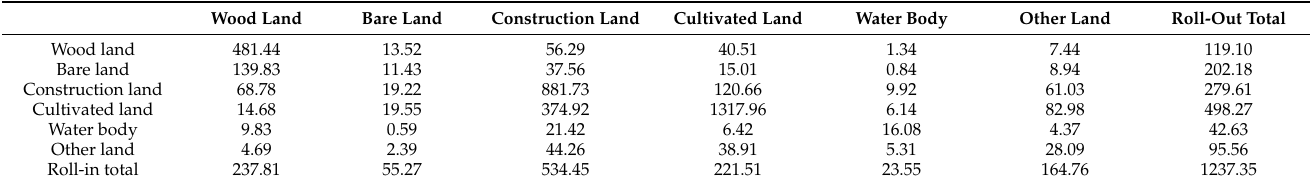
Table 7. Land use transfer matrix of Jiaozuo City from 2011 to 2020 (km 2